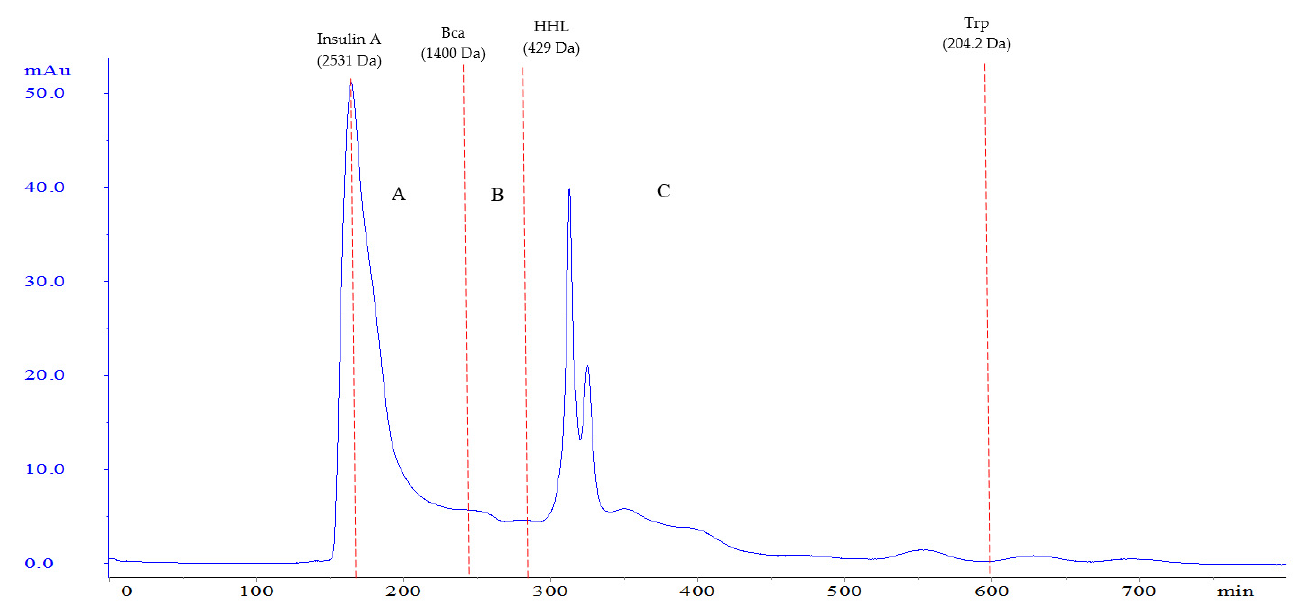
Figure 3. Sephadex G-25 gel filtration chromatography and molecular mass distribution of GTN4H. Insulin A (2531 Da), Bca: bacitracin zinc salt (1400 Da), HHL: hippuryl-histidyl-leucine (429 Da), Trp: tryptophan (204.2 Da). Time: A (160–280 min), B (290–340 min), C (350–440 min). Table 2. In vitro ACE-inhibitory activity of GTN4H protein hydrolysate following fast protein liquid purification (fractions A, B, and C) and further purification of fraction A by RP-HPLC (fractions A1-A5).